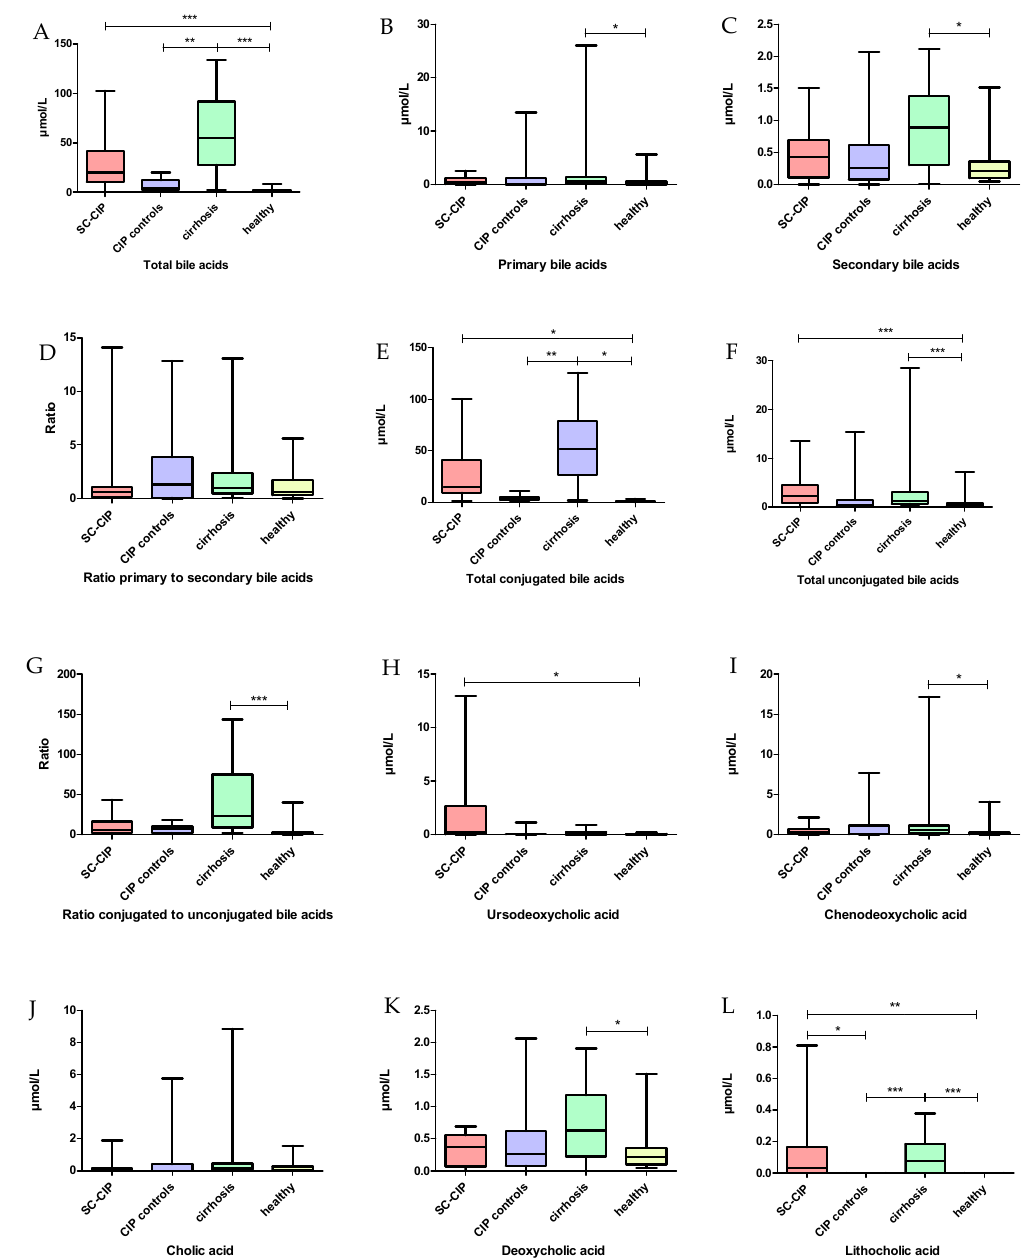
Figure 7. Boxplots for comparison of bile acid levels. ( A ) total bile acids ( B ) primary bile acids ( C ) secondary bile acids ( D ) ratio primary to secondary bile acids ( E ) total conjugated bile acids ( F ) total unconjugated bile acids ( G ) ratio conjugated to unconjugated bile acids ( H ) ursodexocholic acid ( I ) chenodeoxycholic acid ( J ) cholic acid ( K ) desoxycholic acid ( L ) lithocholic acid.SC-CIP (red), CIP controls (violet), cirrhosis (green), healthy (yellow). Significances are indicated with bars and stars within the diagrams. * p ≤ 0.05; ** p ≤ 0.01; *** p ≤ 0.001. For statistical analysis, analysis of variance (ANOVA) with Bonferroni correction was used.